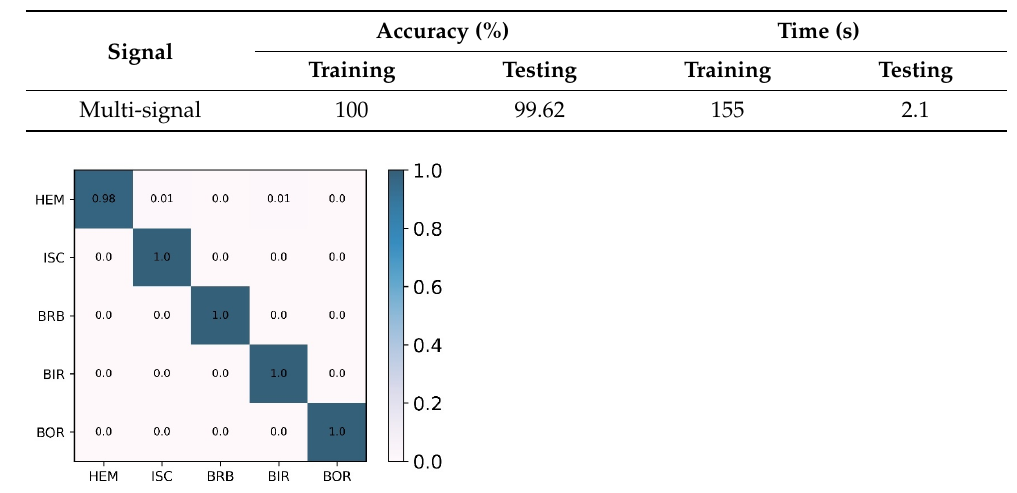
Table 6. Experimental results of multi-signal feature fusion input.